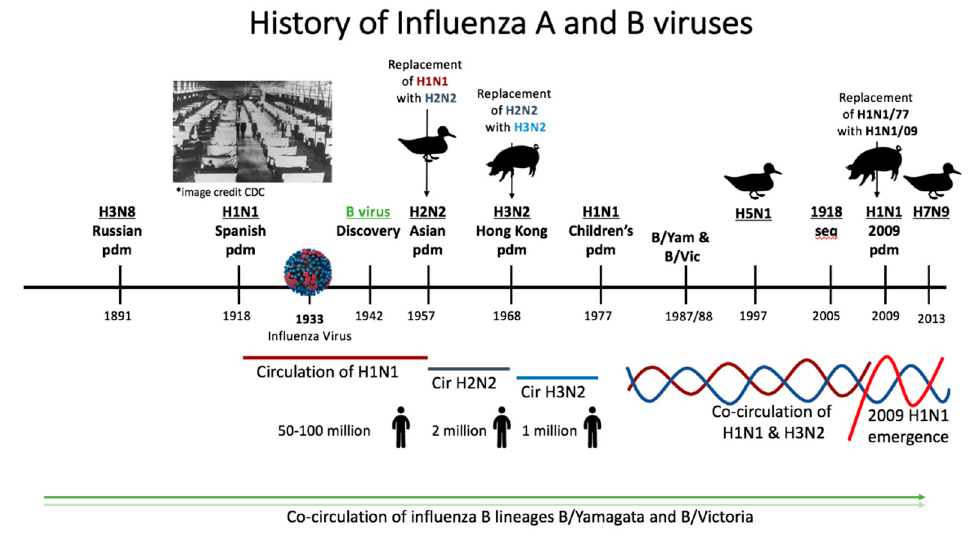
Figure 3. Timeline of the history of influenza virus circulation in humans since 1890s. The timeline shows the history of influenza virus type A and B circulation since 1890. There have been 6 presumptive pandemics in this time period. The Russian pandemic of ~1891 occurred prior to the discovery of the influenza virus and is known only by historical medical records. Seroarcheology has suggested that this outbreak was caused by an H3N8 virus. In 1918 what was known as the Spanish Influenza Pandemic took place. The H1N1 virus which had caused the pandemic was not definitively identified until lung samples from victims of the pandemic were sequenced in 2005. It is estimated that 50 to 100 million deaths were caused by this virus. H1N1 viruses circulated until 1957 when H1N1 was replaced with an H2N2 pandemic virus during the Asian pandemic. The H2N2 virus was replaced with H3N2 during the 1968 Hong Kong pandemic. In 1977, H1N1 resurfaced and since then, H1N1 and H3N2 have co-circulated. In 2009, the emergence of an H1N1 strain of swine origin replaced the former seasonal H1N1 virus ‘lineage’ which was in circulation from the 1977 lineage. In addition to circulating seasonal influenza viruses, avian virus spillover events also lead to human infection. Major avian virus spillover events occurred in 1997 and 2013 for the influenza A viruses H5N1 and H7N9, respectively. During this time period, influenza B viruses have also co-circulated in humans. *Image credit CDC for the 1918 pandemic and the influenza virion [79].